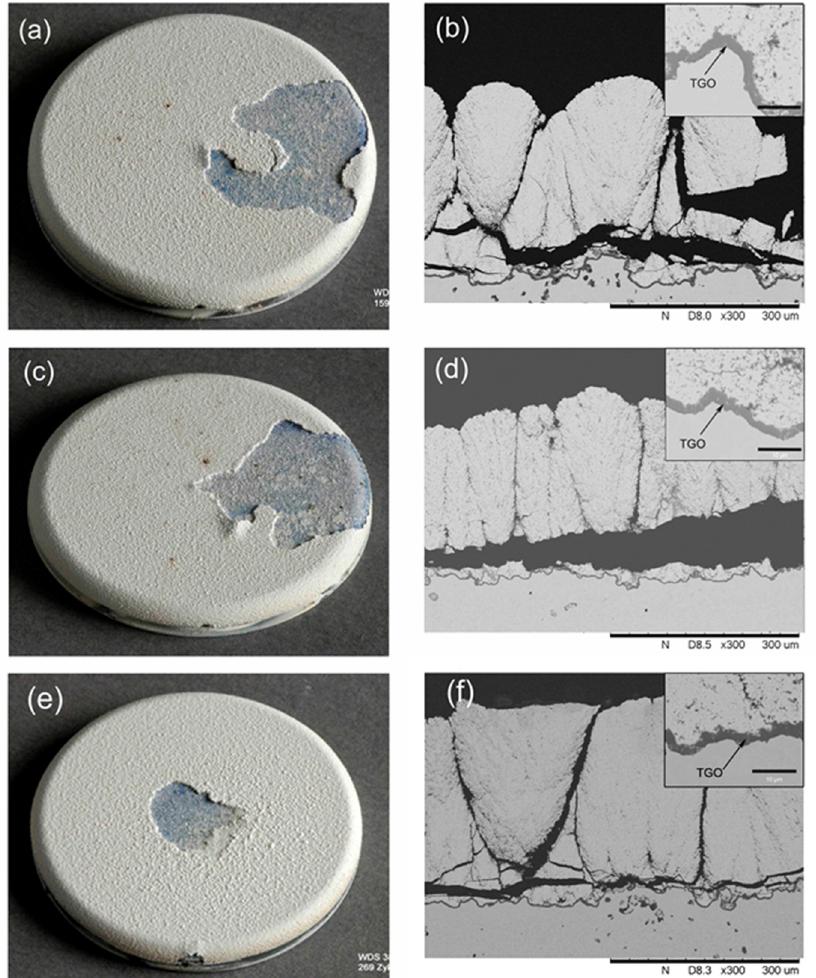
Figure 8. Photographs of thermally ‐ cycled samples: ( a ) Sample M, ( c ) Sample N, and ( e ) Sample O; and cross ‐ section SEM images of thermally ‐ cycled samples: ( b ) Sample M, ( d ) Sample N, and ( f ) Sample O.